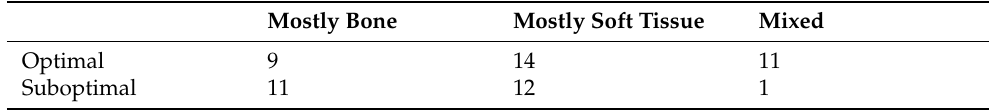
Table 1. Sample quality and pathological characteristics of the